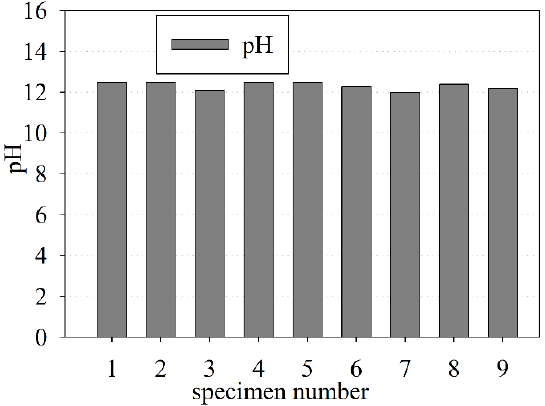
Figure 10. The pH value of the old concrete.